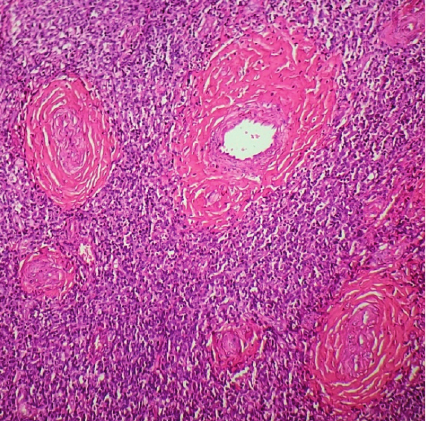
Figure 5: Tissue showing hyalinized blood vessels (H&E stain, ×